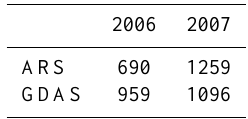
Table 1. Annual ARS and GDAS precipitation (mm) at Little Washita in 2006 and 2007.